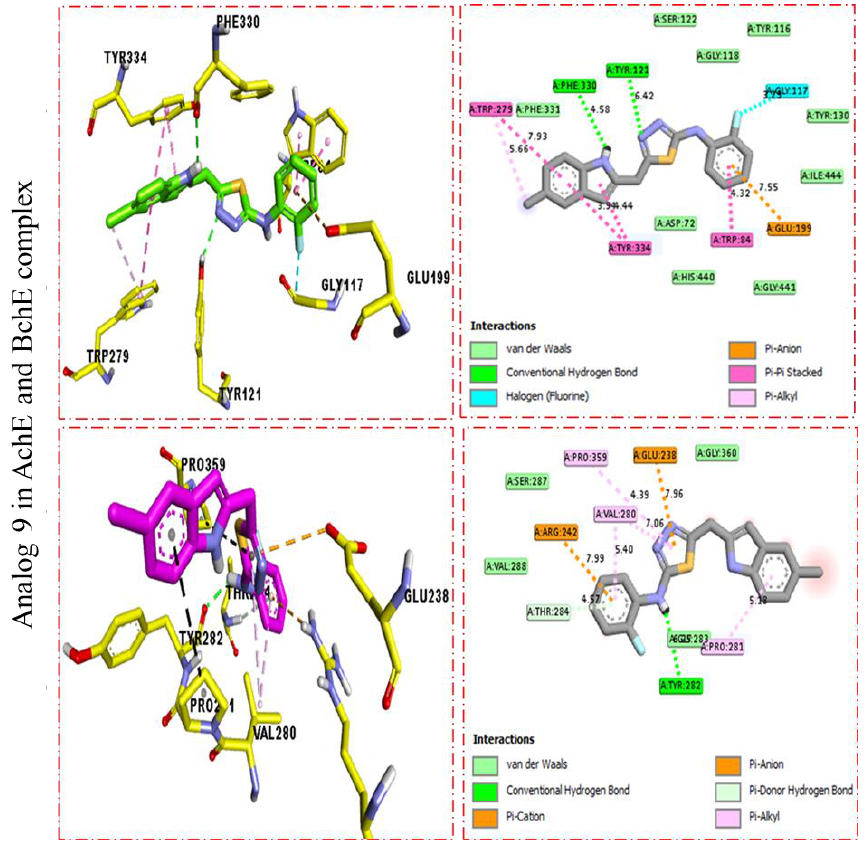
Figure 5. Representation of varied interaction of ligand with enzyme active sites of compound 9 against AchE and BuchE.